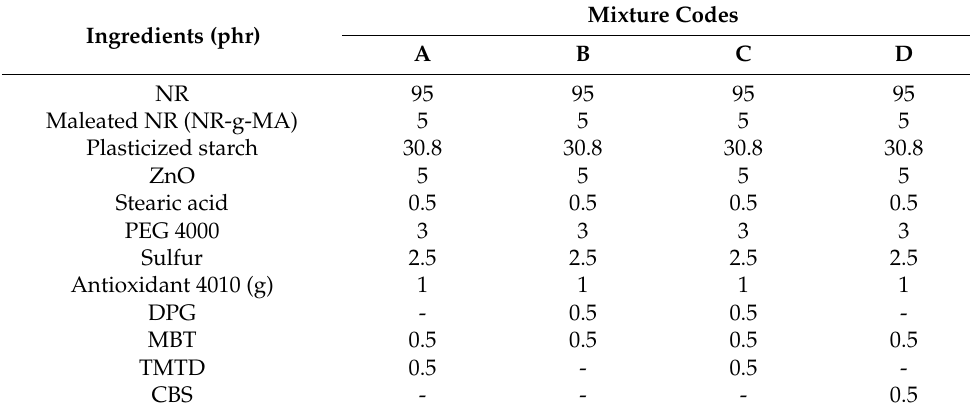
Table 2. The recipes used in the obtained composites. Ingredients